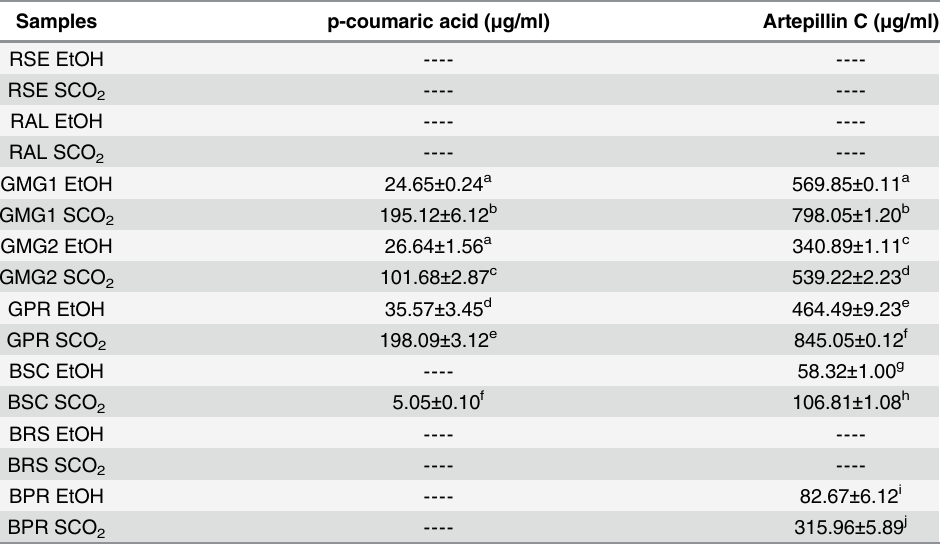
Table 5. Determination of the content of 4-hidroxicinamic acid (p-coumaric acid) and 3,5-diprenil- 4-hidroxicinamic (Artepillin C) of extracts from different samples of Brazilian samples obtained by ethanolic extraction (EtOH) and by SFE (SCO 2 ).